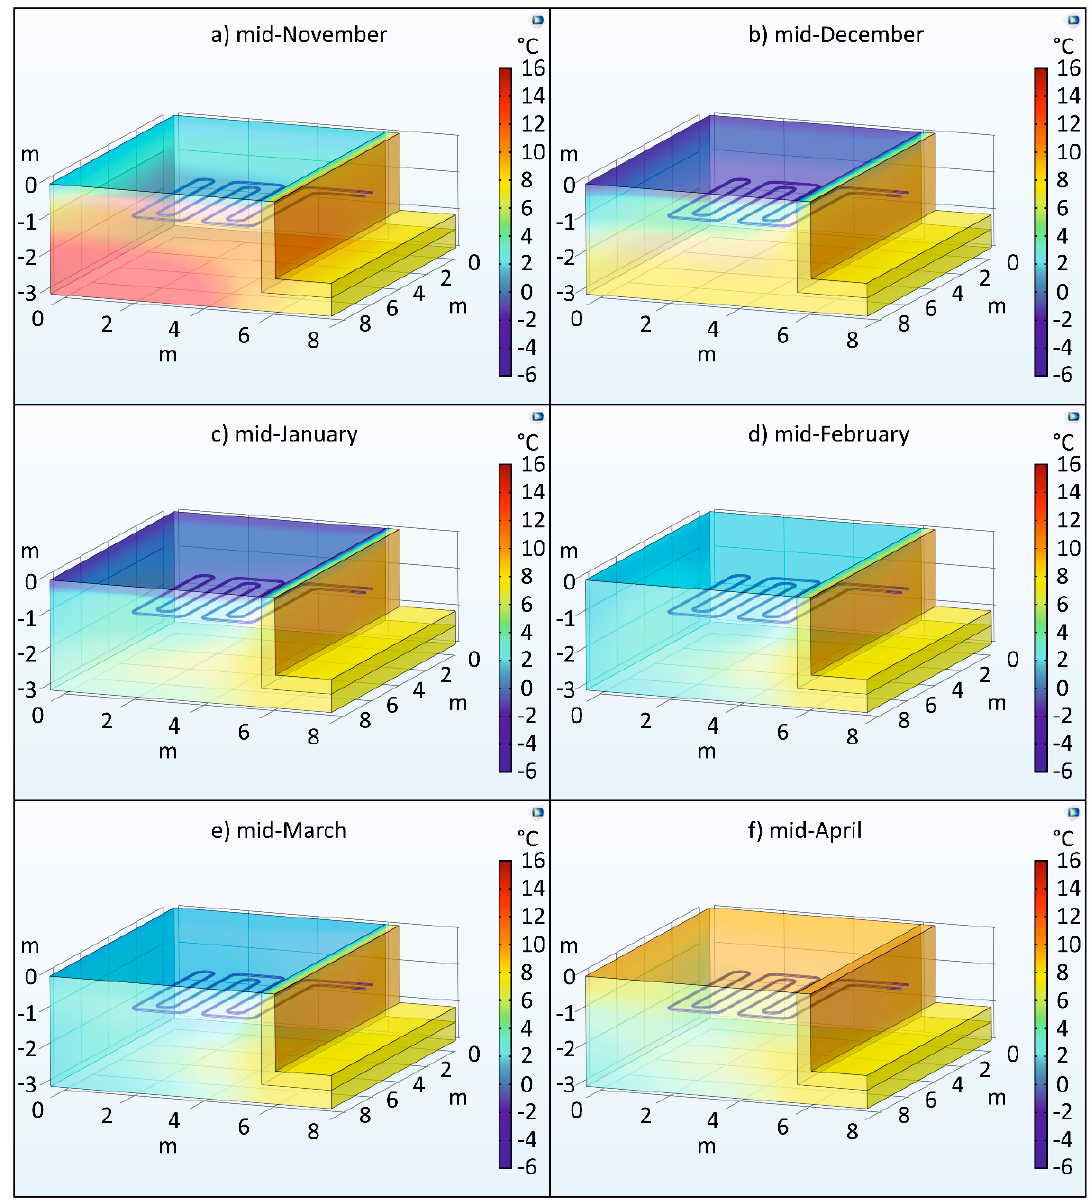
Figure 3. The tri-dimensional temperature gradients for the simulation case 1—HGHE with no auxiliary heat sources: ( a ) mid-November; ( b ) mid-December; ( c ) mid-January; ( d ) mid-February; ( e ) mid-March; ( f ) mid-April.